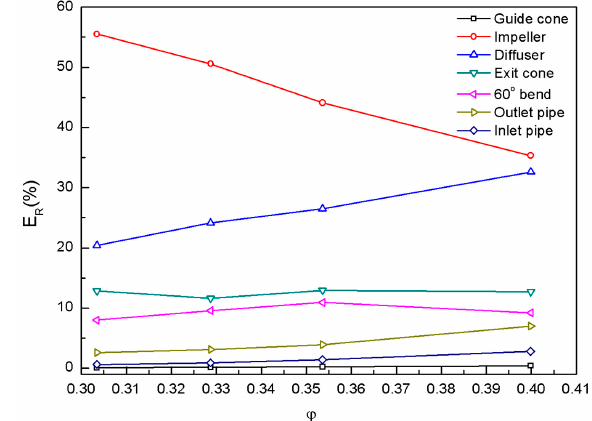
. Figure 7. Percentage contributions of S(cid:4662) (cid:2888) of different components to the overall entropy generation Figure 7. Percentage contributions of S D of di ff erent components to the overall entropy generation rate rate of the whole flow passage for four discharges. of the whole flow passage for four